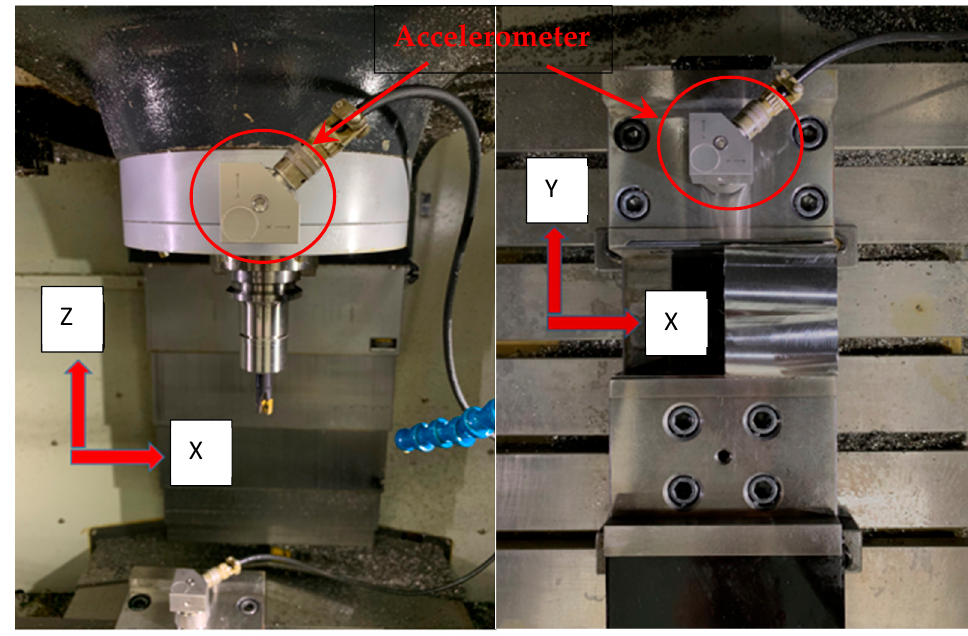
Figure 1. Two tri-axial accelerometers on spindle ( left ) and vise ( right ). Table 2. Cutting parameters, accumulated volume removal and operation